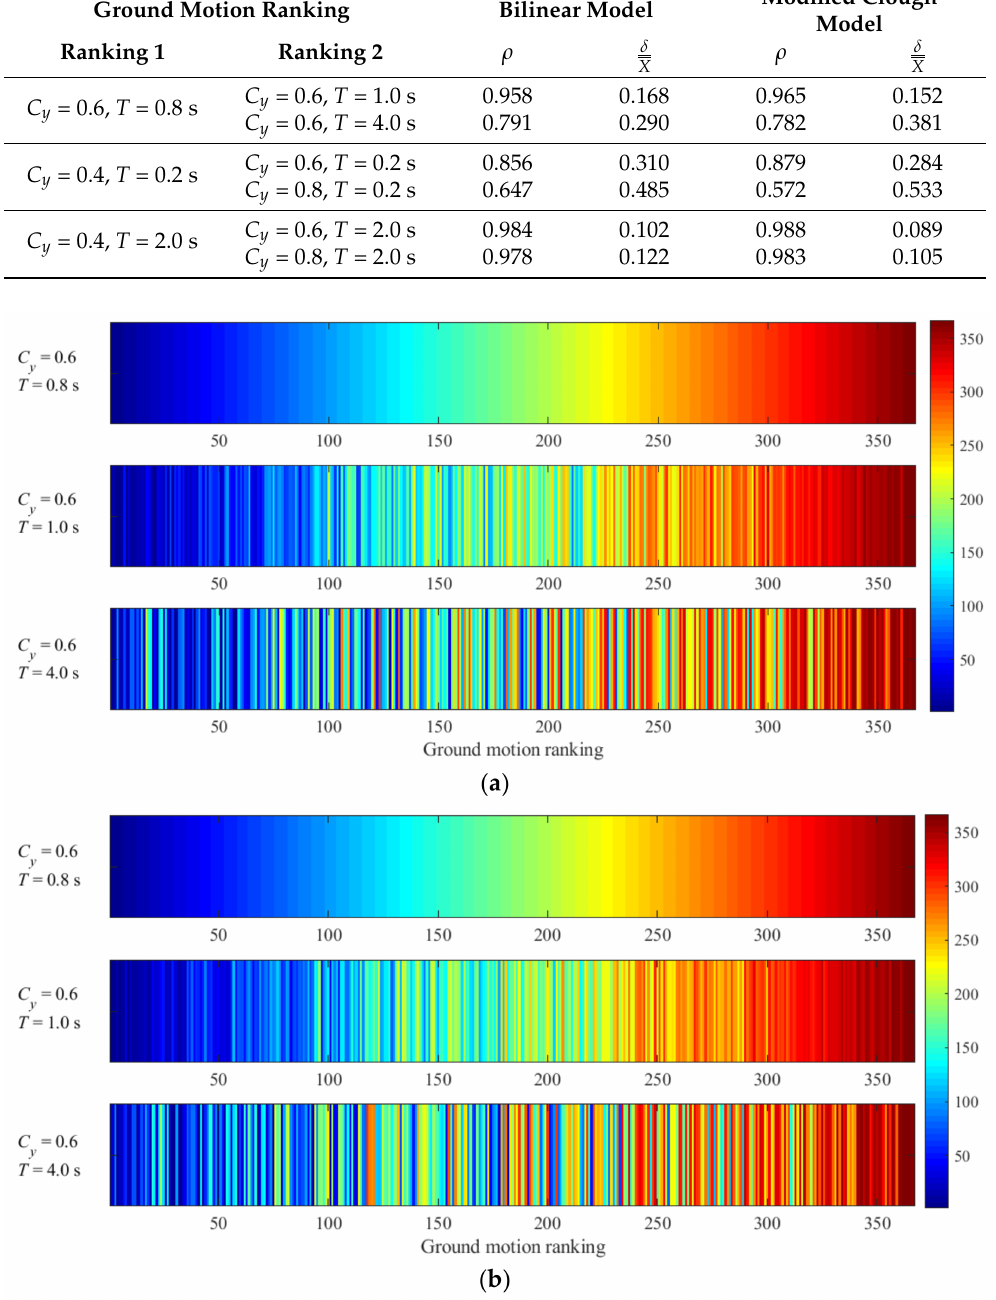
Figure 8. Comparison of displacement response rankings at different periodic points when the yield strength coefficient is constant. ( a ) Bilinear model ( C y = 0.6), ( b ) modified Clough model ( C y =